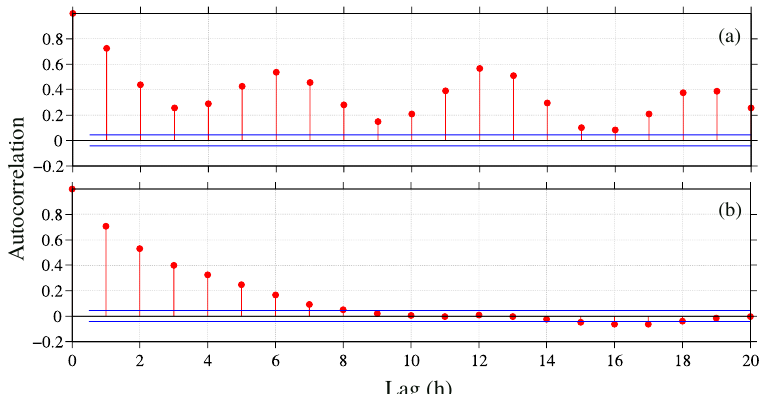
Figure 11. Autocorrelation function of the time series of the differences between directional spread measured at two locations: ( a ) autocorrelation of differences between the wave buoy and the ADCP-E directional spread; and ( b ) autocorrelation of the differences between the radar directional spread estimates obtained at the buoy and ADCP-E sites. The confidence bounds are shown in